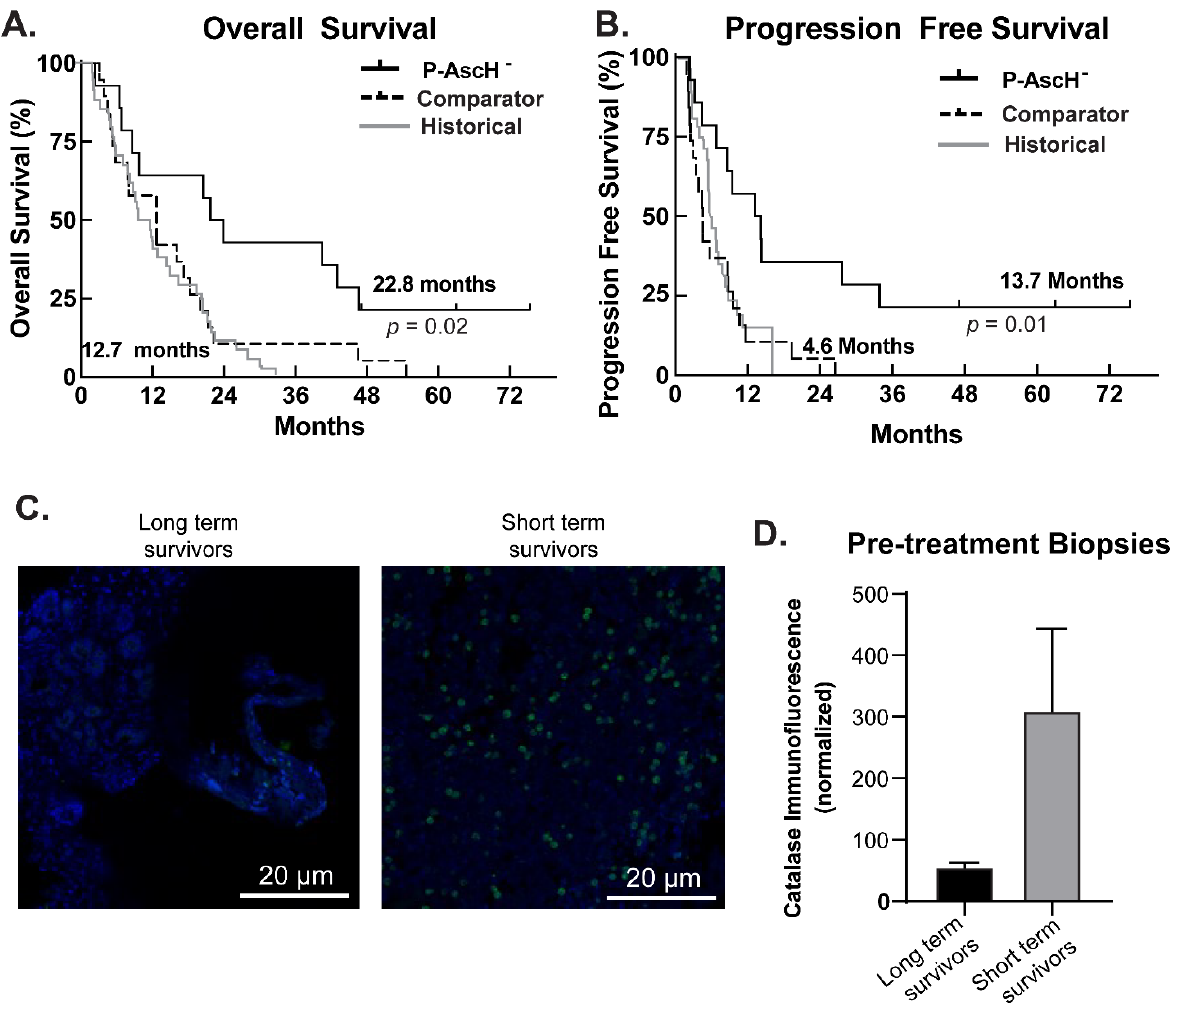
Figure 5. Catalase levels may predict patient outcomes after treatment with P-AscH − . ( A ) Overall survival from phase